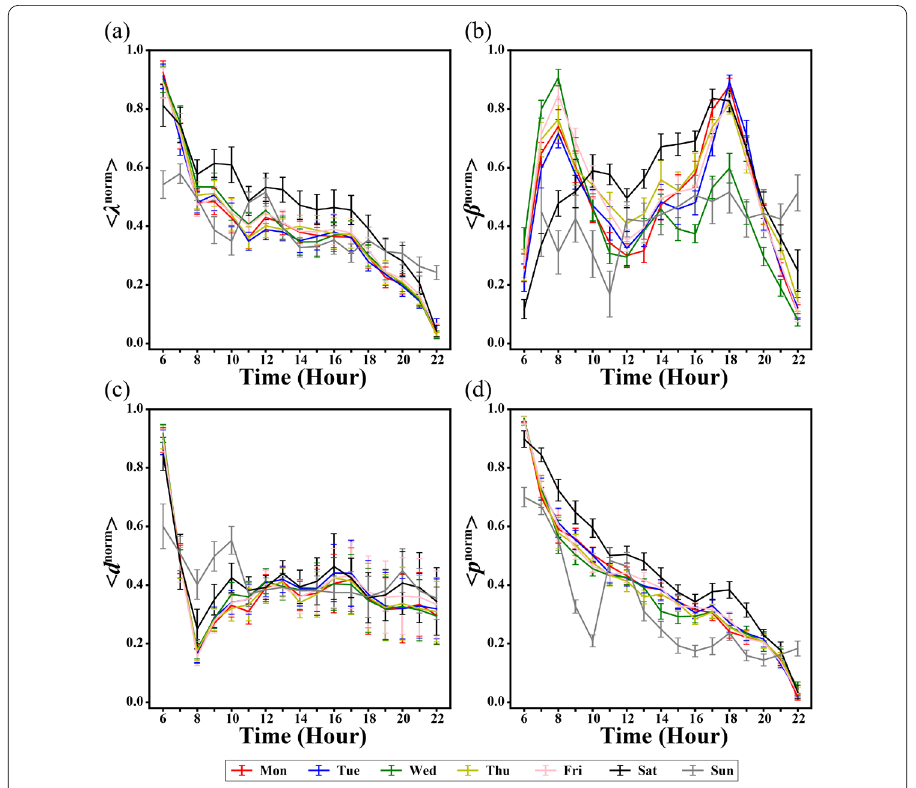
Figure 4 Temporal patterns of ( a ) coupling strength (cid:3) λ norm (cid:4) , ( b ) speed ratio (cid:3) β norm (cid:4) , ( c ) average trip distance (cid:3) d norm (cid:4) , and ( d ) fraction of trips from ordinary zones (cid:3) p norm (cid:4) . The (cid:3) ... (cid:4) symbol denotes the